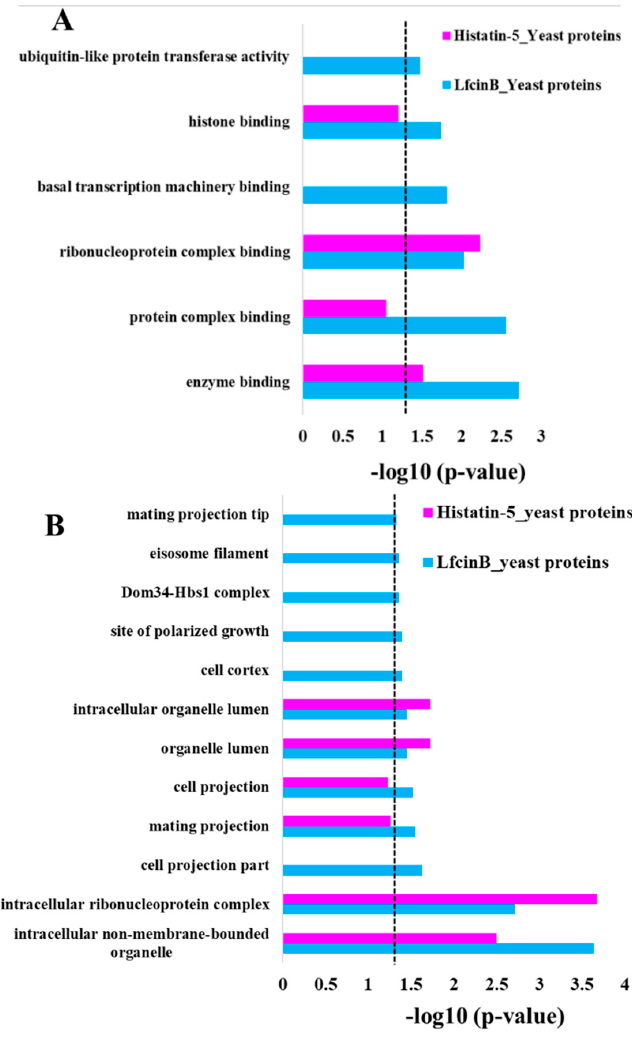
Figure 5. Functional enrichment of Lfcin B and Histatin-5 hits obtained from yeast proteome microarrays. The significant enrichment categories of Lfcin B and Histatin-5 of yeast-binding proteins. ( A ) Enrichment in molecular function ( B ) Enrichment in cellular component. (dotted line indicates the p -value of 0.05).